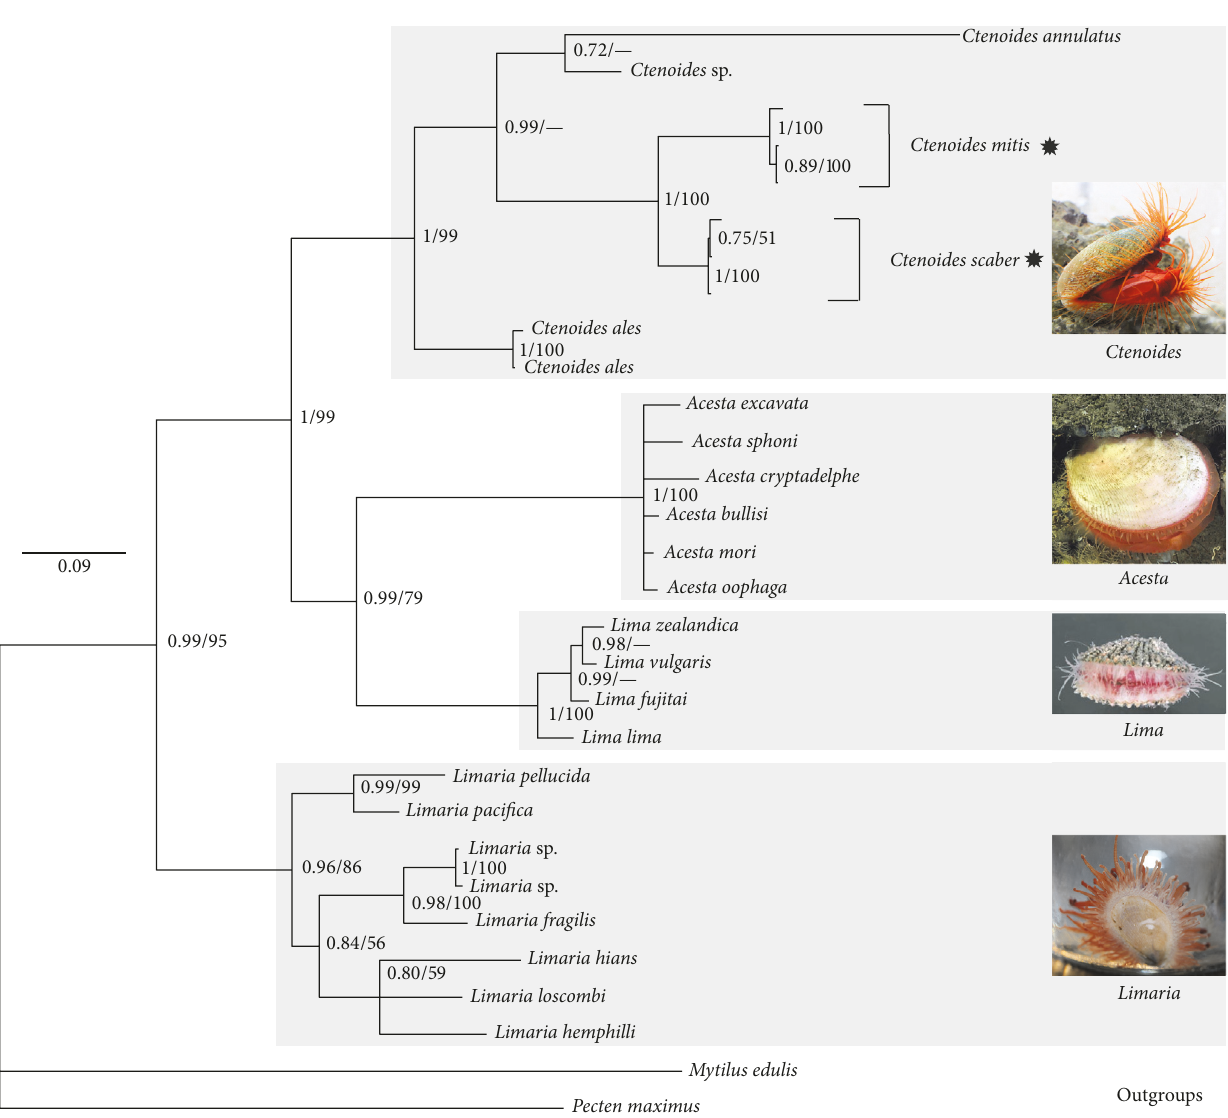
Figure 2: Bayesian phylogeny based on a concatenated genes (COI, 28S, and H3) showing phylogenetic position of Ctenoides scaber and C. mitis (black stars) within the Limidae family. Node labels indicating posterior probabilities and bootstrap values. The Ctenoides photo (C. scaber) was taken by J. Li. The Acesta photo (Acesta sp .) is Figure 2 C of Gagnon et al. [37] and was reprinted with permission from the authors. The Lima photo ( L. caribaea ) was reprinted with permission from the American Museum of Natural History. The Limaria photo (Limaria sp .) was taken by L.